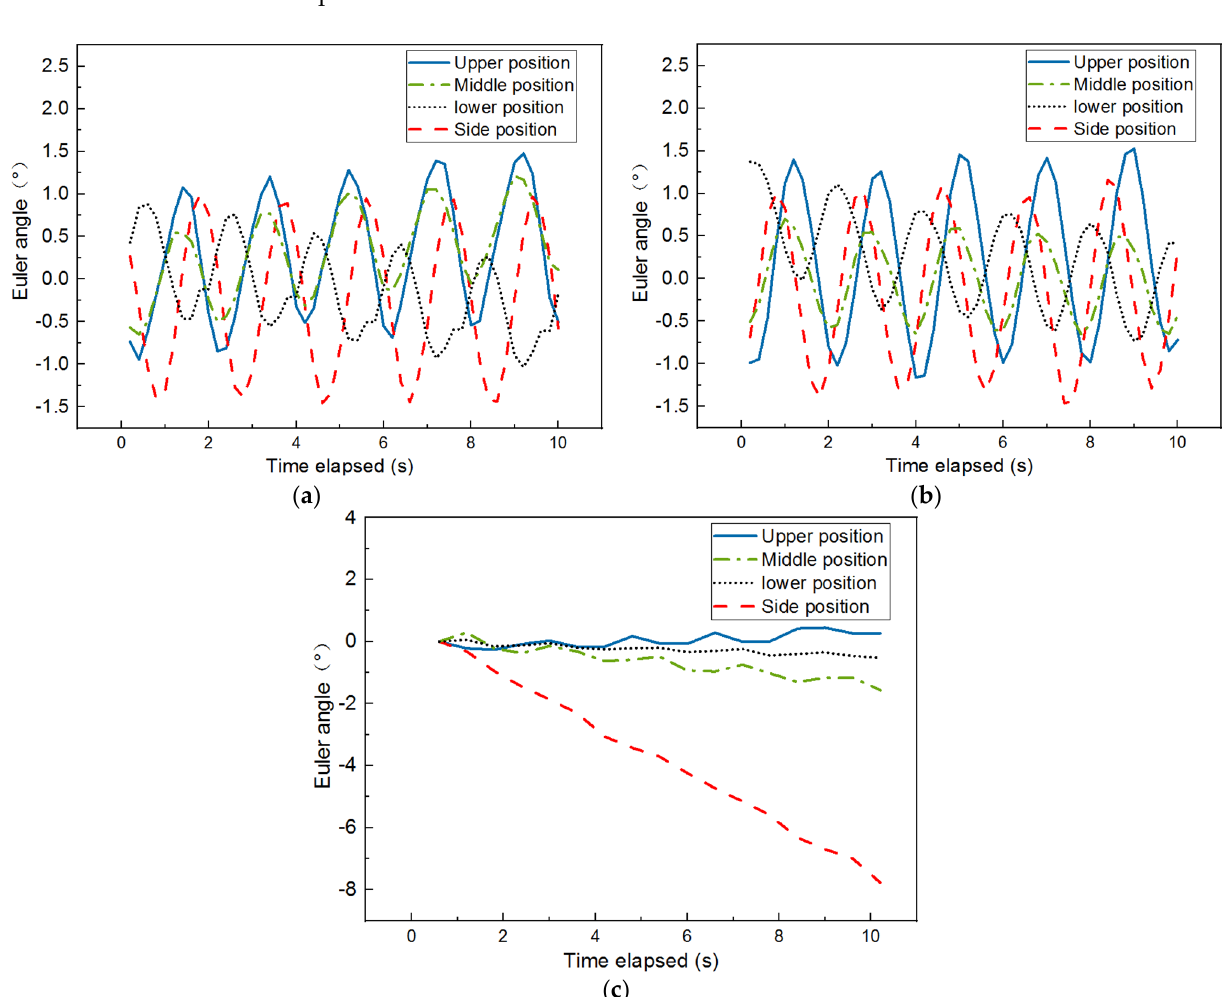
Figure 17. Euler angle results measured at four different positions of the specimen with optimal combination of gyratory parameters: ( a ) X direction, ( b ) Y direction, and ( c ) Z direction.